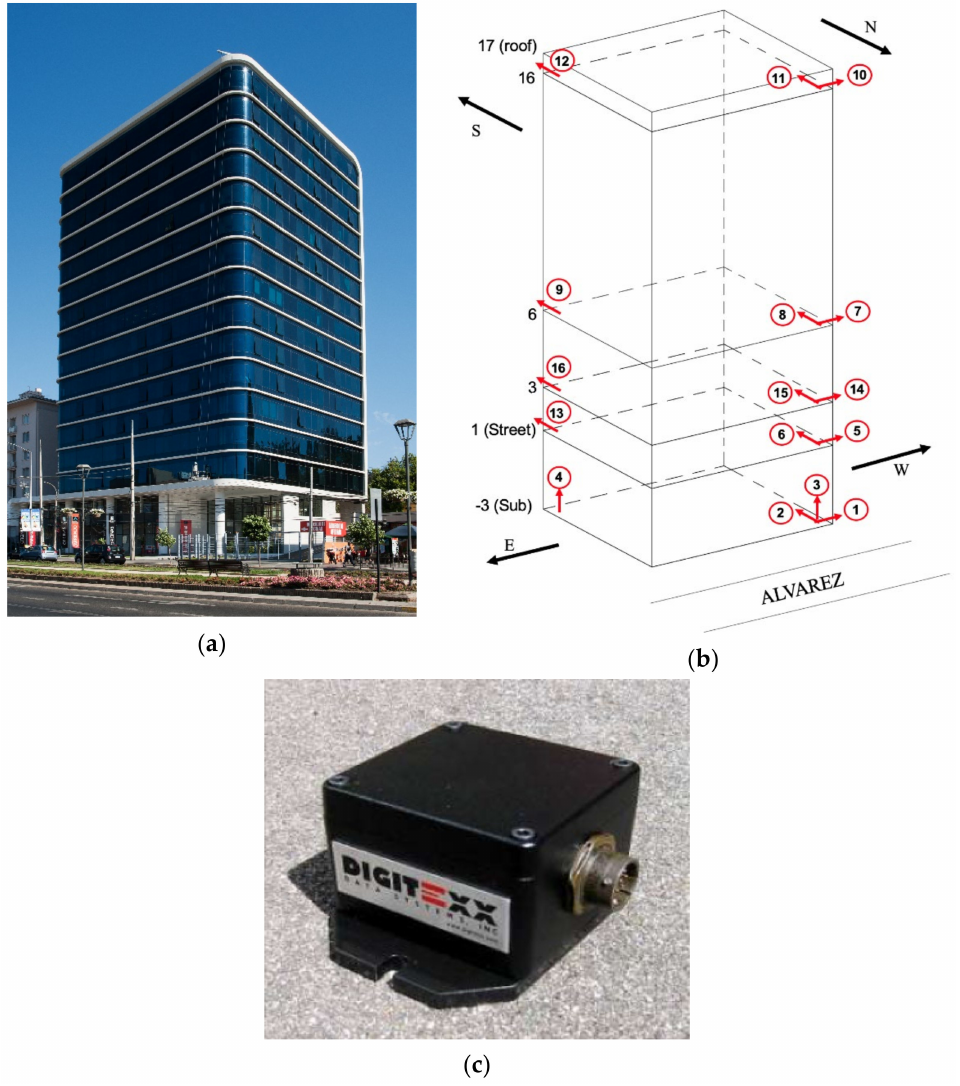
Figure 1. The case study building. ( a ) Northwest side of view; ( b ) accelerometers’ location; ( c ) Digitexx accelerometers model D-110U installed in the